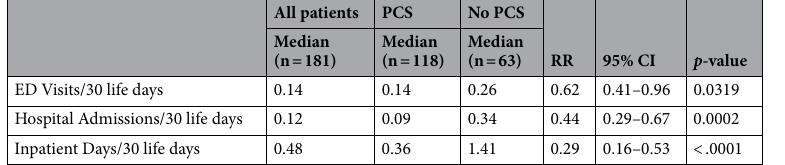
Table 2. Summary of life metrics and relative risk from negative binomial regression controlling for age, sex, race, and primary site for patients referred to palliative care services at a single institution, 2014–2018. PCS Palliative care services, RR Risk ratio, CI Confidence interval, ED Emergency department.